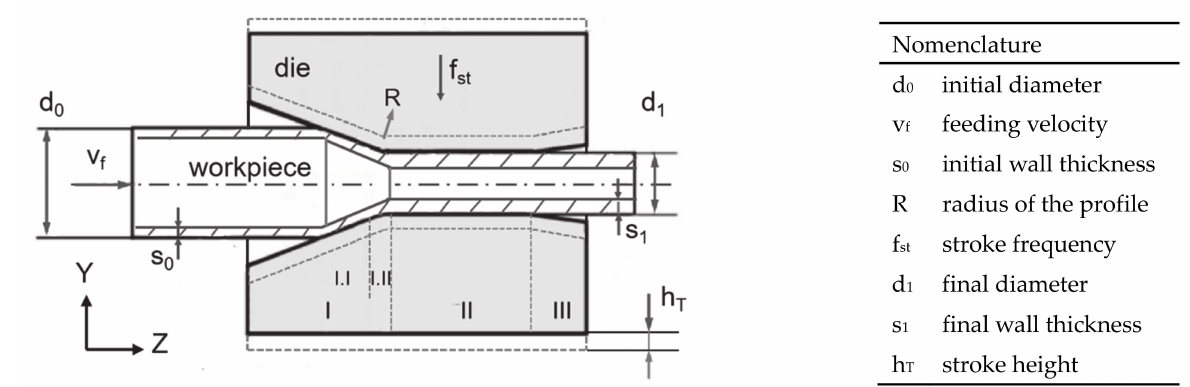
Figure 1. Principle of infeed rotary swaging of tube without